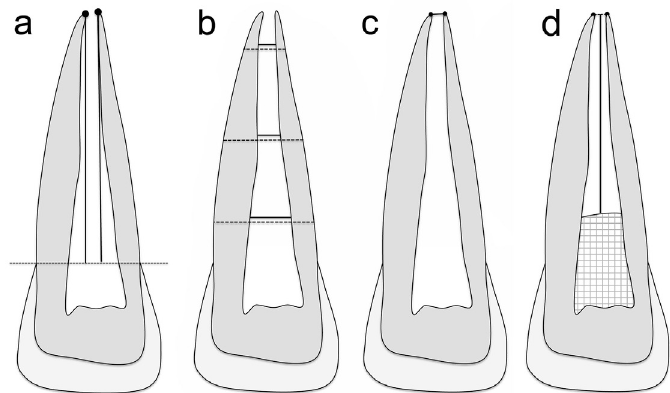
Figure 1- Measurements of radiographic images. (a) Root length: perpendicular line from the end of the root on the mesial and distal side to an imaginary line connecting both cementoenamel junctions; (b) Root width (dotted line) and pulp space (full line) at the apical, middle, and cervical third; (c) Apical diameter; (d) MTA placement from the